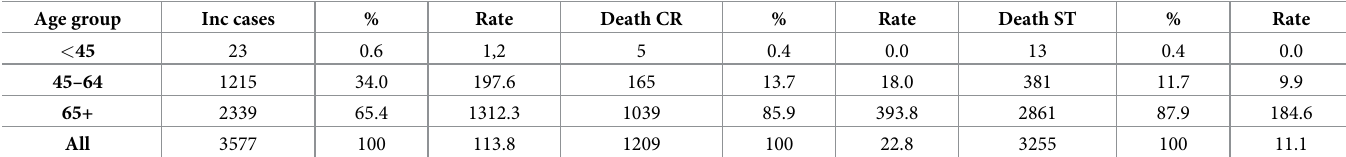
Table 2. Number and percentage of incident cases of prostate cancer and deaths by age group. Age